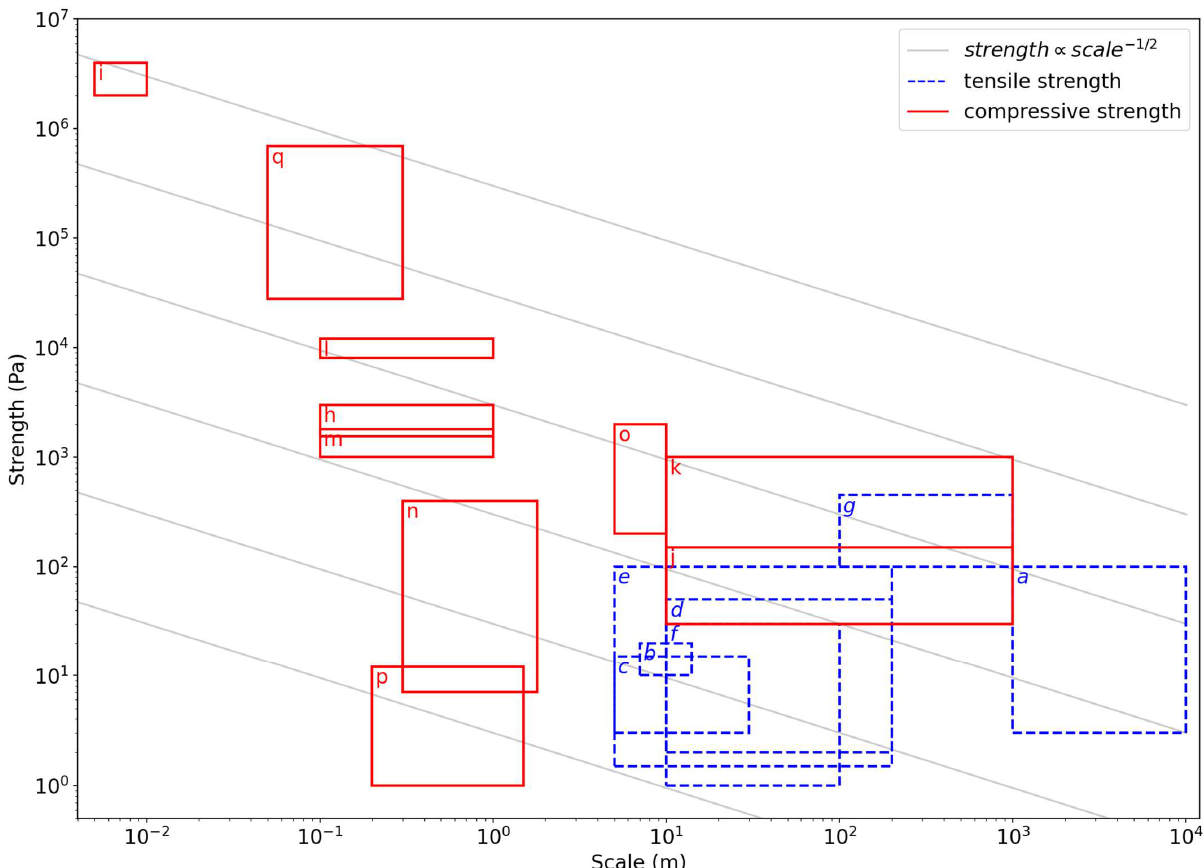
Figure 8. Summary of tensile and compressive strength for cometary materials from this work and the previously published literature. Each box represents a domain of scale/strength from a specific study. The thin gray lines in the background illustrate the typical qualitative relationship between strength and scale. References: (a) Biele + 2009 [23], (b) Thomas + 2015 [73], (c) Grousssin + 2015 [70],